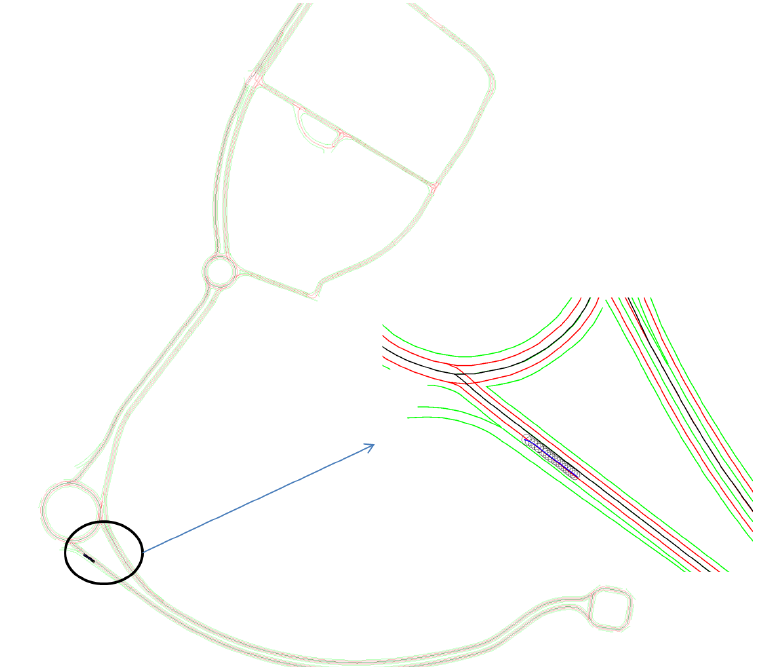
Figure 11. Projection of the vehicle position on the map. This map of Compiègne (France) has been charted by a professional in the framework of the Robotex